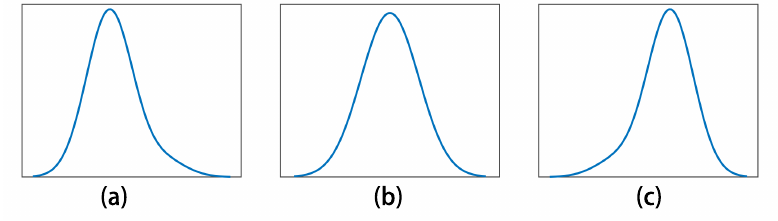
Figure 3. Probability distribution shape and skew: ( a ) positive skew; ( b ) zero skew; ( c ) negative